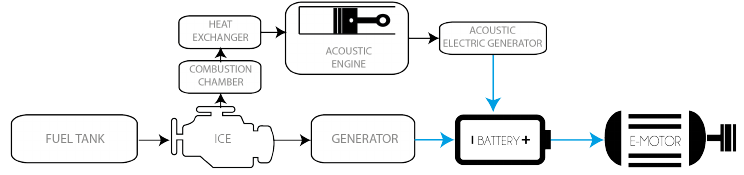
Figure 7. A diagram of the configuration of